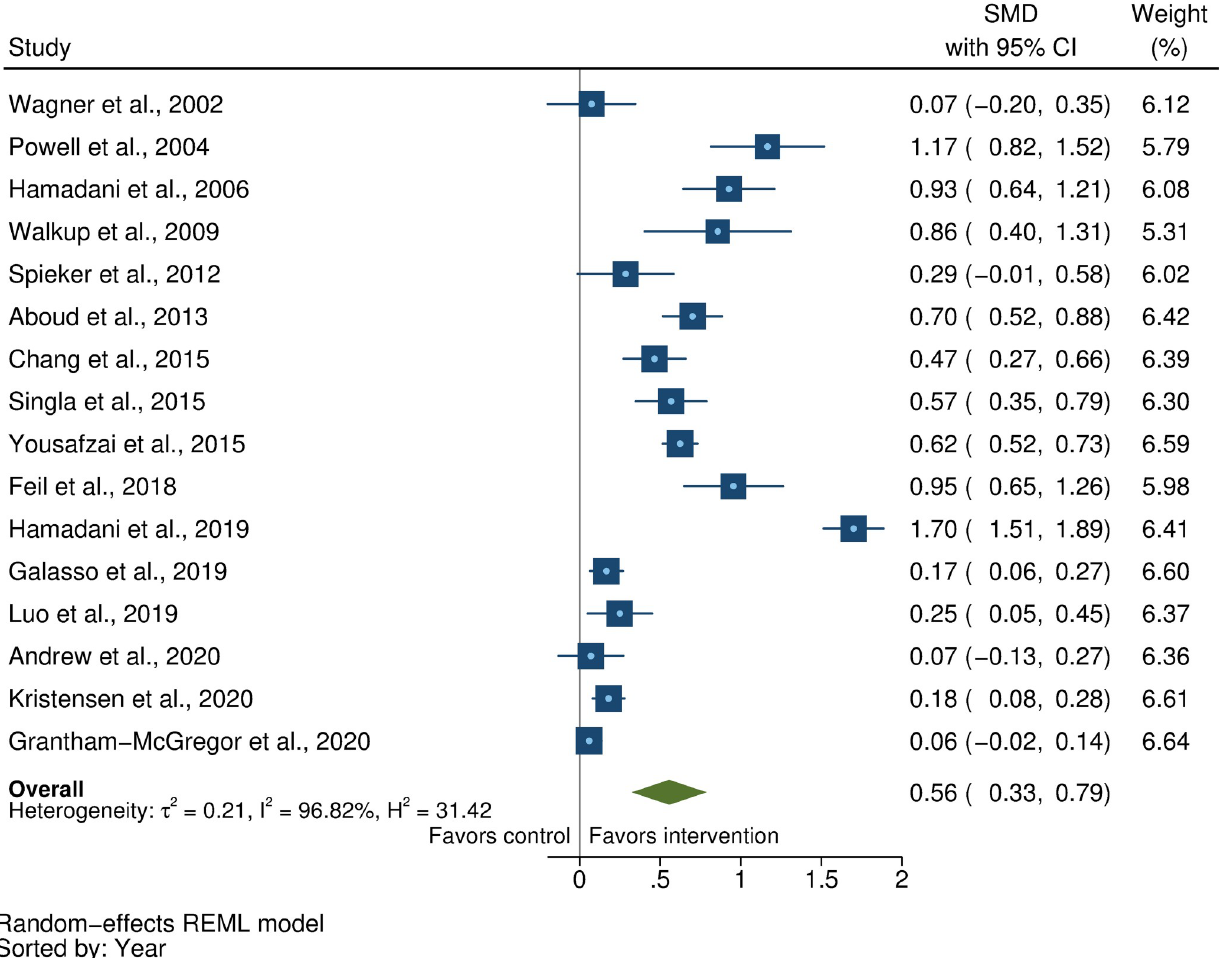
Fig 8. Forest plot for the effect of parenting interventions on parenting knowledge. Blue squares represent the SMD for each study, with the size of the square being proportional to the study weight. The whiskers extending from each side of the square represent the range of the 95% CI. The green diamond shows the overall pooled effect size using a random-effects model, which is centered at the point estimate and the diamond width representing the 95% CI. SMD, standardized mean